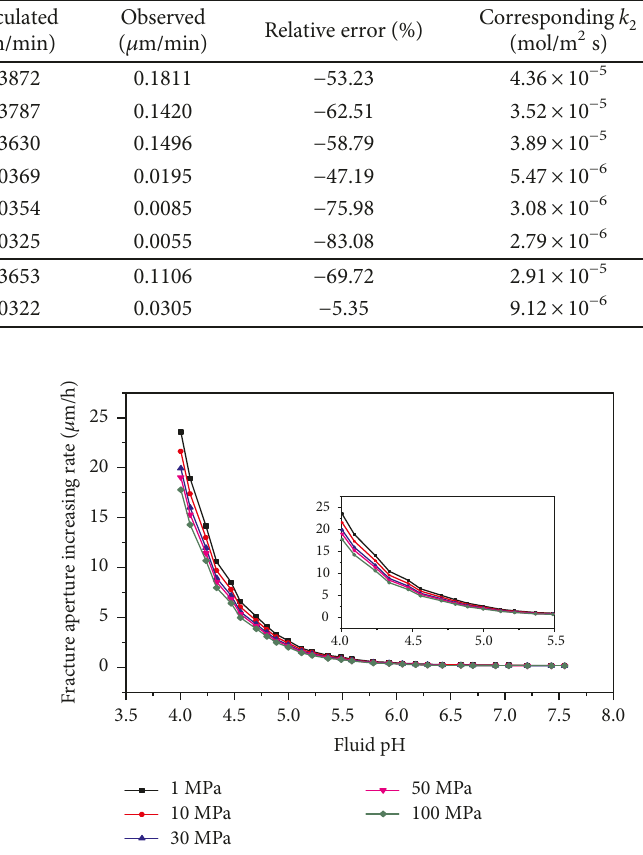
Figure 15: The relationship between fracture increasing rate and fl uid acidity caused by calcite free-face